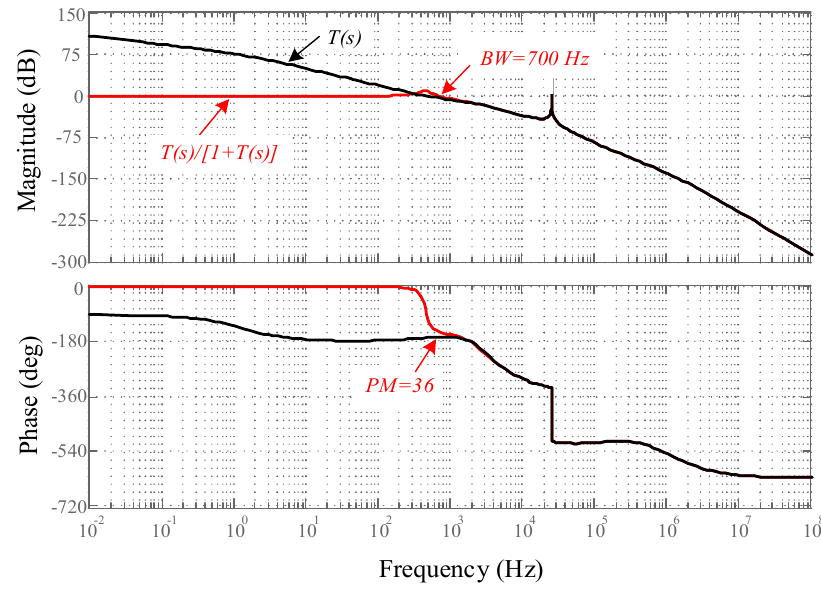
Figure 11. Bode plot of the proposed control scheme of MFBDI.